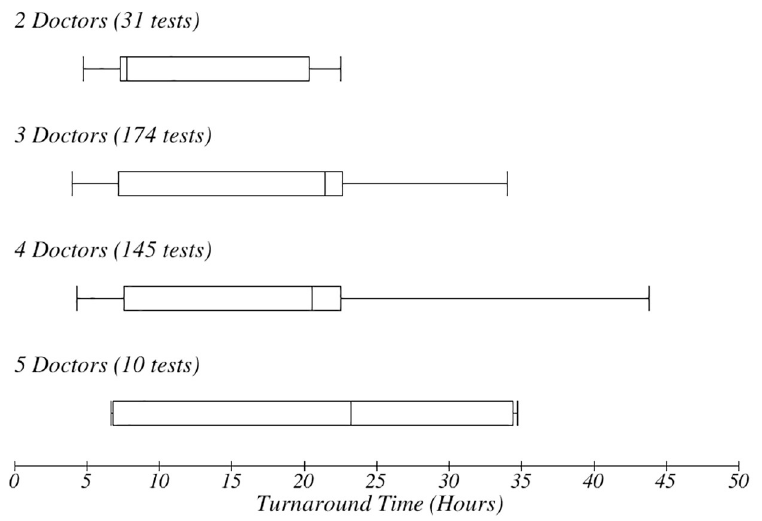
Fig 5. Number of doctors and impact on TAT. The box-plot shows the number of doctors present when the test was ordered and impact on